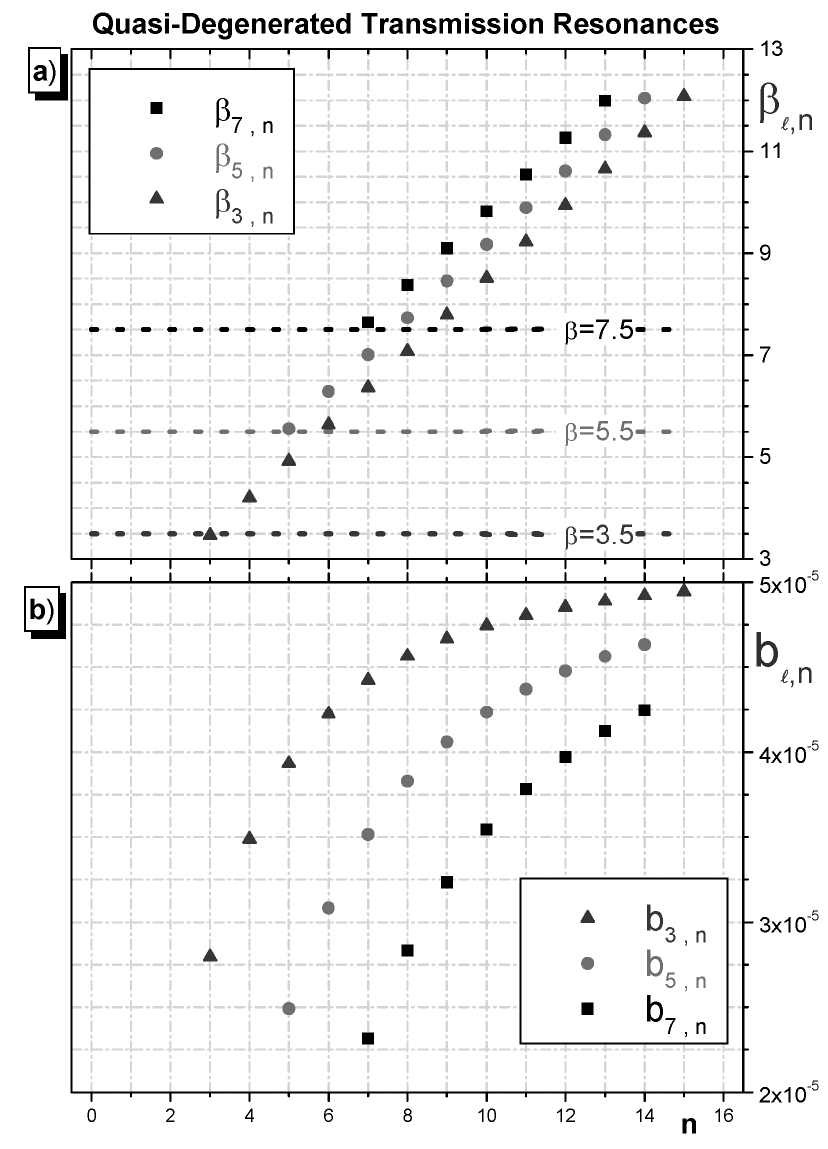
Figure 10 - Similar to Fig. 9, but for odd multipoles (cid:96) = 3 , 5 , 7 , this figure shows the behavior of positions ( β (cid:96),n , top panel– a ) and widths ( b (cid:96),n , bottom panel– b ) as function of n in the case of the Quasi-Degenerated Transmission